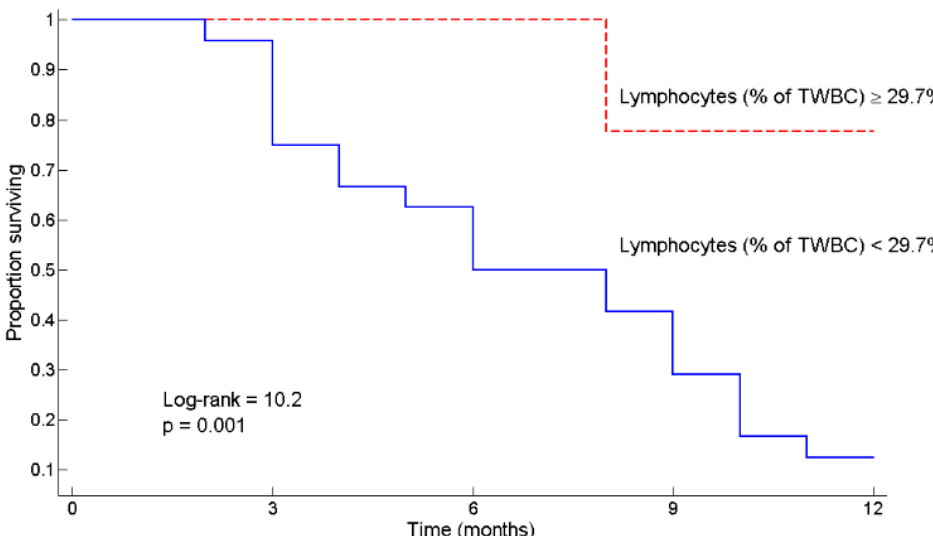
Figure 2. Kaplan–Meier survival curves according to lymphocytes expressed as percentage of total white blood cells ≥ 29.7% and < 29.7%. The 12-month mortality rate varied from 22% for patients with lymphocytes ≥ 29.7% of total white blood cells to 87% for patients with lymphocytes < 29.7% of total white blood cells. TWBC: total white blood cells. Figure 3. Circulating absolute lymphocytes are not significantly associated with body weight (Kg) (Figure 3a). Circulating lymphocytes as percentage of Total White Blood Cells are significantly linked to body weight (Kg) (Figure 3b).